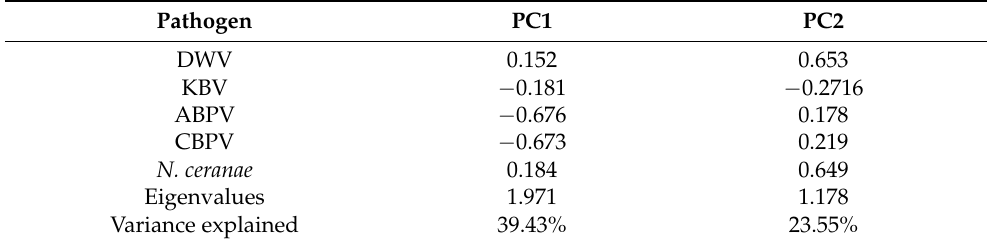
Table 3. Relationship between Principal Components (PC1 and PC2) and pathogen abundance variables.